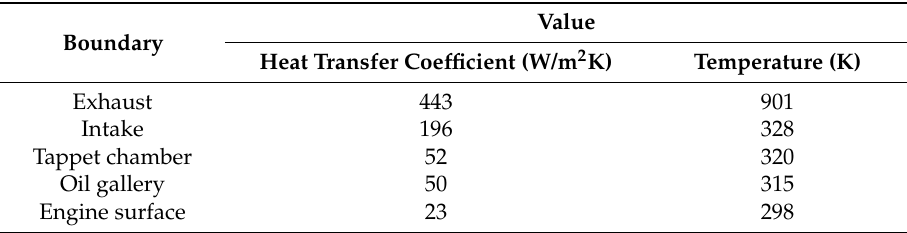
Table 2. Steady thermal boundary in other parts.